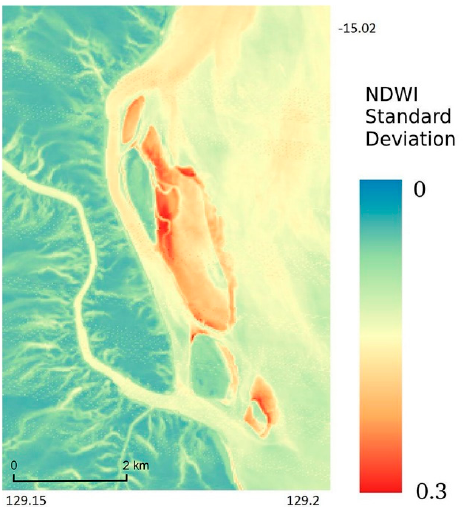
Figure 5. Intertidal extents model (ITEM) confidence layer, Keep River West Bank, Northern Territory: The confidence layer shows the average variation in normalised difference water index NDWI values across each tidal percentile used in the ITEM product. Higher values indicate regions of change between water and land that are not driven by tidal influences [16].